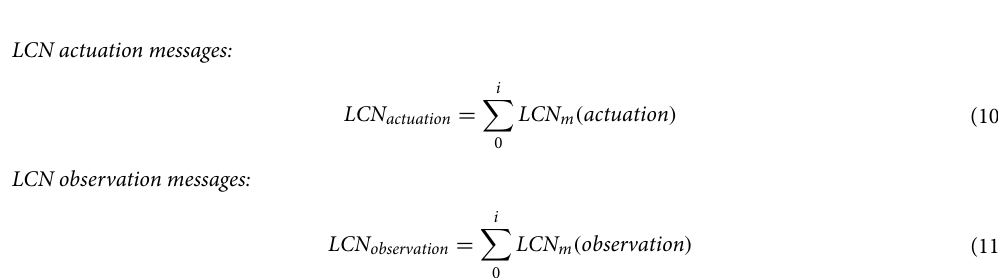
Figure 6. Packets loss due to failed fog